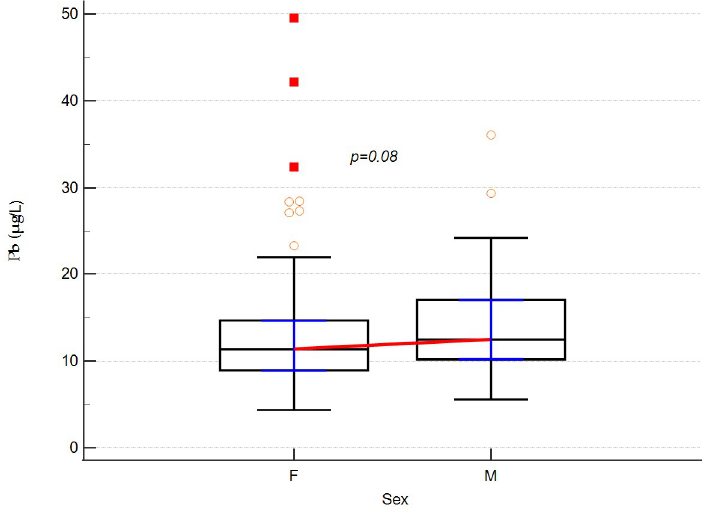
Figure 1. Lead levels with regard to sex. Medians and IQRs are shown. Empty dots represent individual data. Red squares are outliers.